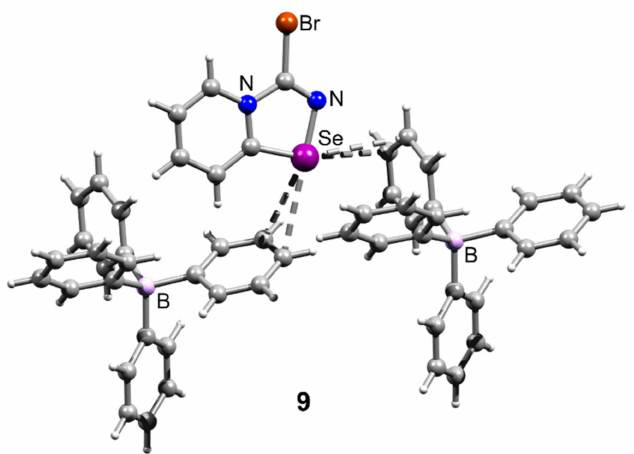
Figure 6. Ball-and-stick representation of the crystal structure of 9 , demonstrating attractive Se ··· π interactions between the selenadiazole cation and two neighboring BPh 4 anions. Grey and light-grey spheres represent carbon and hydrogen,